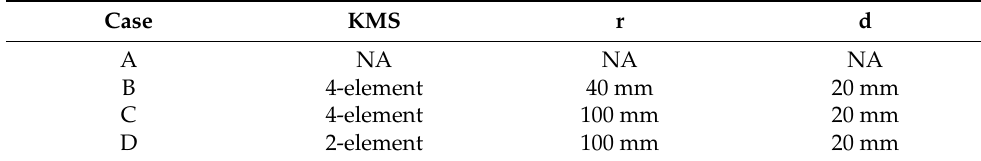
Table 3. Experimental analysis cases.